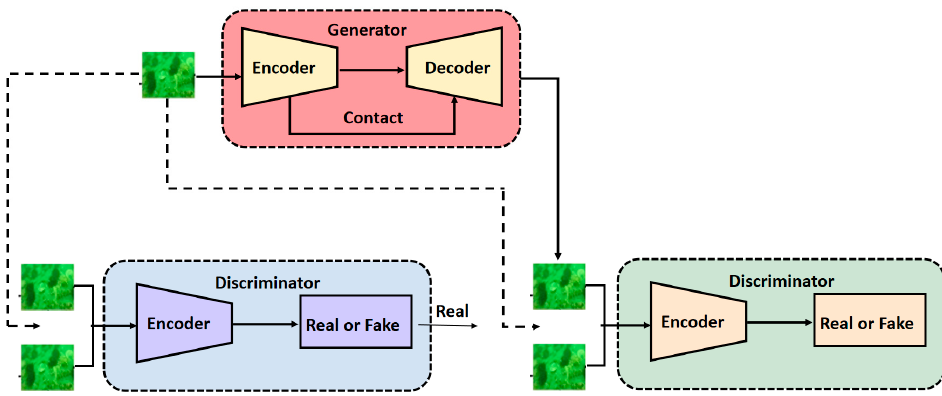
Figure 2. Schematic diagram of underwater image enhancement network.